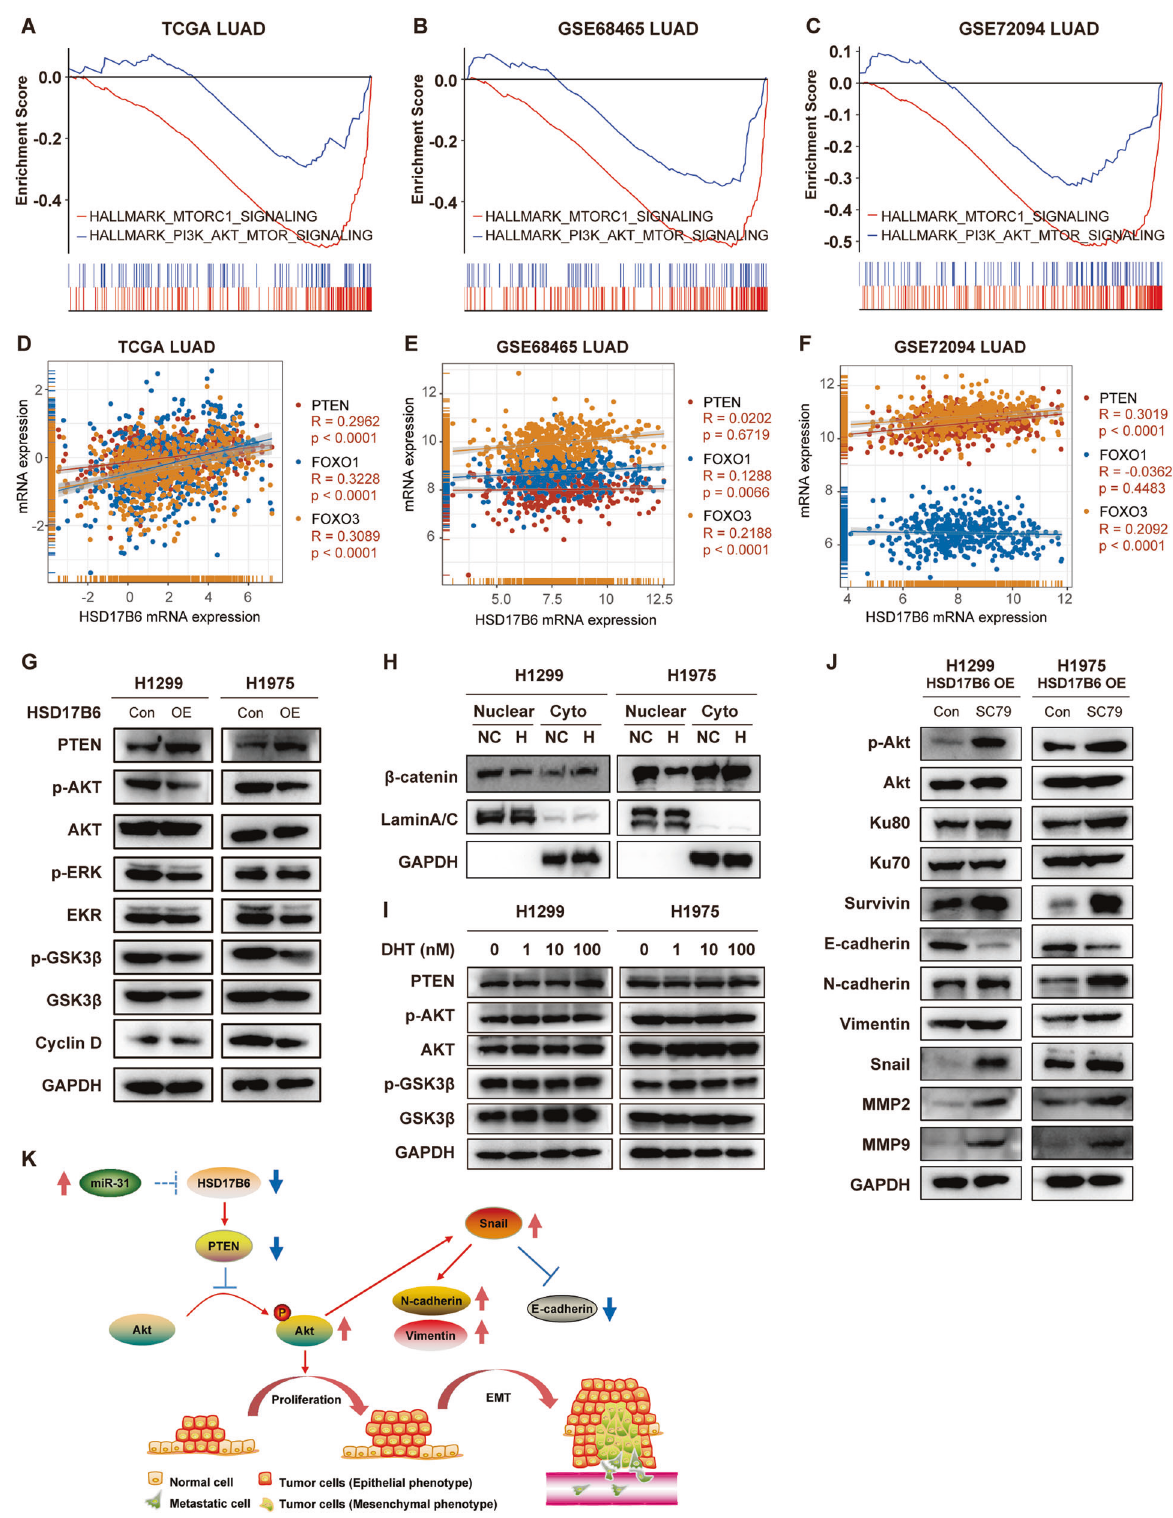
expression (Fig. S5). Radiotherapy, which kills tumor cells mainly by DNA damage, is an important therapeutic strategy against lung cancer, and weakened DNA damage repair capacity promotes radiosensitivity. HSD17B6 overexpression suppressed Ku70, Ku80, and survivin expression, which are crucial proteins involved in